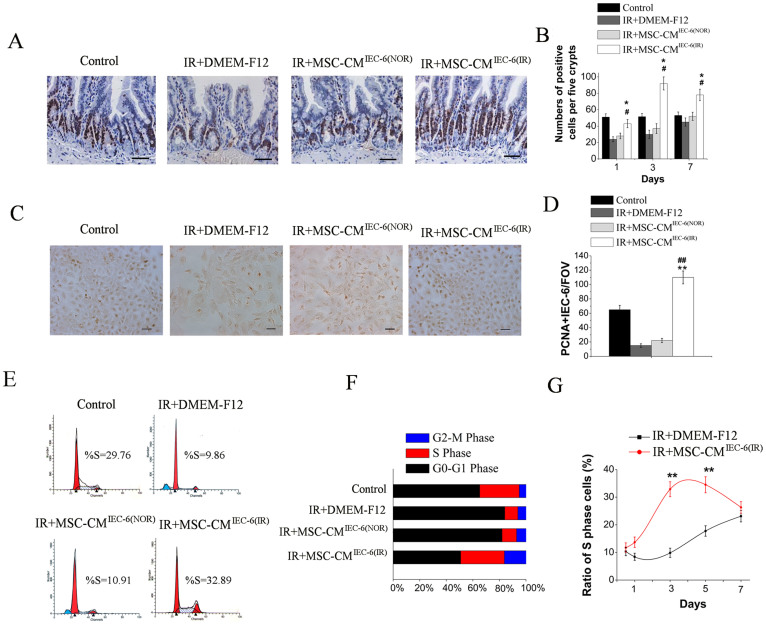
MSC-CMIEC-6(IR) increases the proliferation of intestinal epithelial cells after radiation in vivo and in vitro.(A) The proliferation of intestinal epithelial cells was examined by immunohistochemical staining with proliferating cell nuclear antigen (PCNA). Intestinal tissue samples were collected and analyzed 3 days after radiation. Scale bars 50 μm. (B) Quantification of PCNA-positive cells. n = 3 in each group. The number of positive cells in 5 crypts was scored in 100 crypts per section and reported as mean ± SD. *, P < 0.05 versus IR + DMEM-F12, #, P < 0.05 versus IR + MSC-CMIEC-6(NOR). (C) Immunohistochemical staining of IEC-6 cells with PCNA 3 days after radiation. Scale bars 50 μm. (D) Quantification of PCNA-positive cells for the treatment groups in panel C. Data are reported as mean ± SD for 10 random fields per wells from four replicate wells per group. **, P < 0.05 versus IR + DMEM-F12, ##, P < 0.05 versus IR + MSC-CMIEC-6(NOR). FOV, field of view. (E) The cell cycle status of IEC-6 cells following IR and/or co-culture with MSC-CMIEC-6(NOR) or MSC-CMIEC-6(IR) were detected by flow cytometry based on DNA content. (F) The percentage of S phase cells and G1 phase cells for each culture condition was determined. The proportions of cells in S phase were as follows: Control: 29.76%; IR + DMEM-F12: 9.86%; IR + MSC-CMIEC-6(NOR): 10.91%; IR + MSC-CMIEC-6(IR): 32.89%. (G) The ratio of S phase cells was examined 1, 3, 5, 7 days after radiation. Data represent mean ± SD of three independent experiments. **, P < 0.05 versus IR + DMEM-F12.